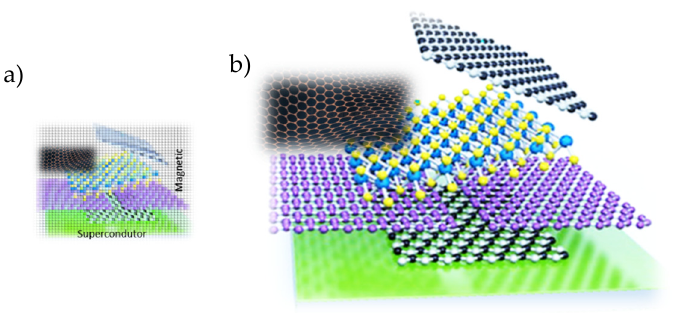
Figure 2. Heterostructures composed of two-dimensional layers by stacking different materials with controlled rotation angles and interfaces, similar to a bitmap of multi properties obtained at will ( a ), to fabricate hybrid devices ( b ) with localized tunable magnetic and superconducting properties.